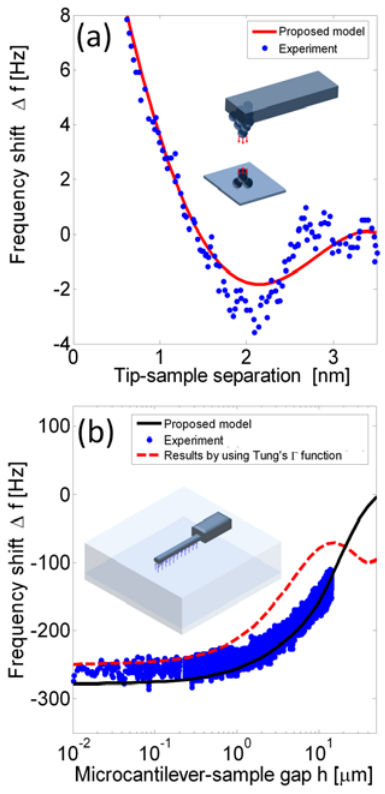
Figure 2. Frequency shift versus separation for: ( a ) a vacuum case with prediction by the proposed method (solid line) and experimental data (dots) [16], and ( b ) a liquid case with prediction by proposed method (solid line), experimental data (dots) [2], and results (dashed replaced by approximation line) by the proposed method but with Γ r